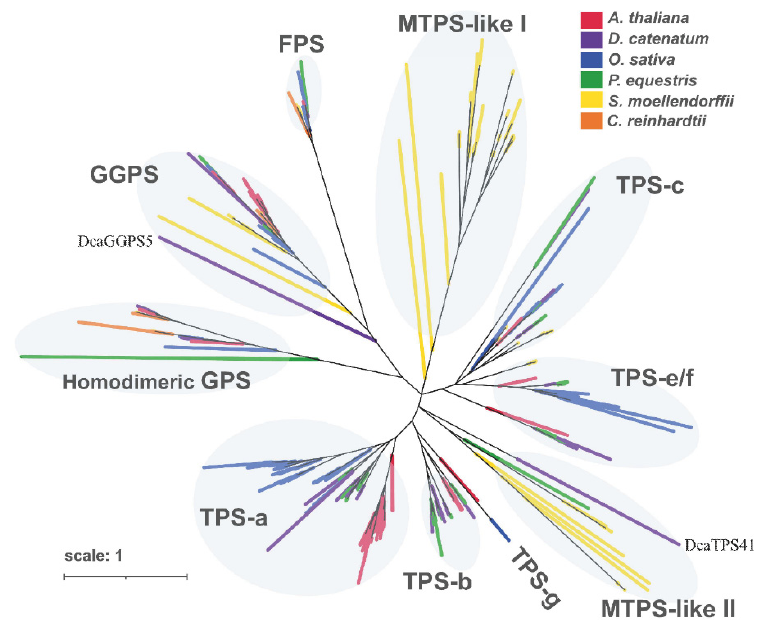
Figure 3. Phylogenetic analysis of PS-TPS proteins in Arabidopsis thaliana , Dendrobium catenatum , Oryza sativa , Phalaenopsis equestris , Selaginella moellendorffi , and Chlamydomonas reinhardtii . A total of 71 PSs and 247 TPSs were used to construct the unrooted maximum likelihood phylogenies.